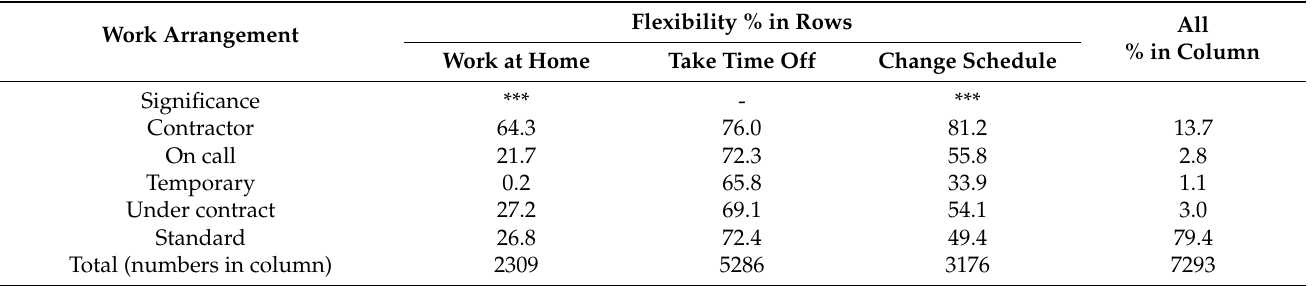
Table 4. Flexibility by work arrangement, pooled GSS-QWL